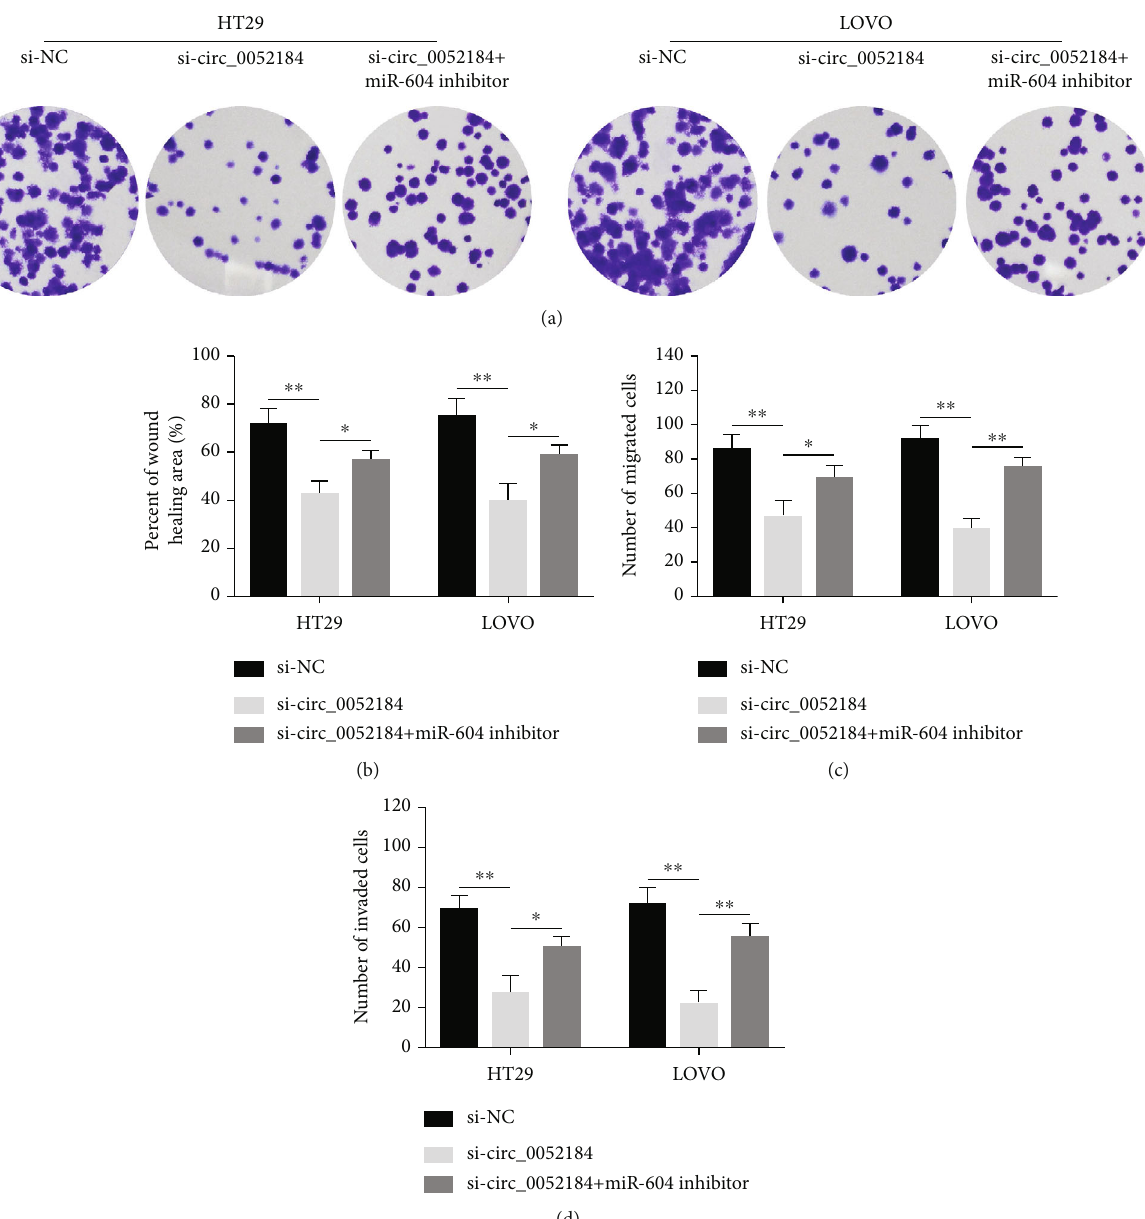
Figure 4: circ_0052184 regulated colorectal cancer cell proliferation, migration, and invasion by targeting miR-604. miR-604 inhibitor and siRNA-circ_0052184 or corresponding control were transfected into LoVo and HT29 cells. (a – d) Cell proliferation, migration, and invasion of cells were detected by colony formation assay (a), wound healing assay (b), and transwell assay (c, d). ∗ p < 0 : 05 , ∗∗ p < 0 : 01 , ∗∗∗ p < 0 : 001